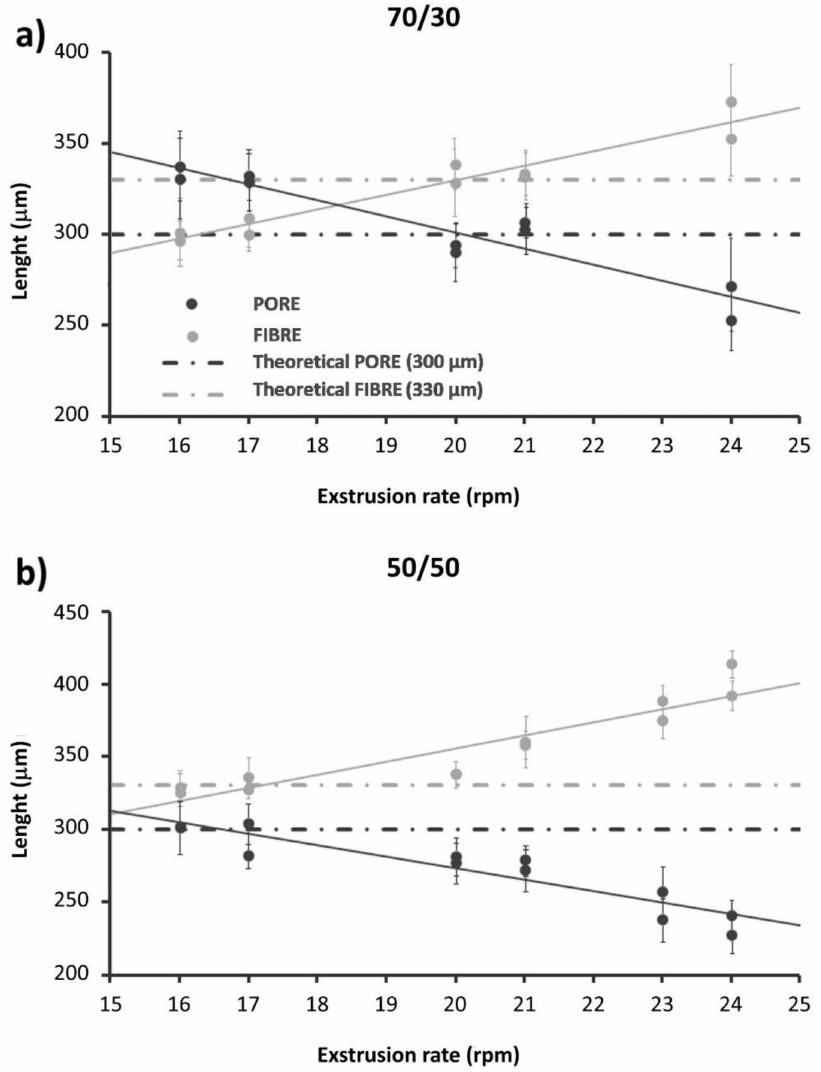
Figure 1. Fibre diameter (FIBRE, light grey) and pore size (PORE, hard grey) as a function of the extrusion rate, evaluated by optical microscope for ( a ) 70/30 and ( b ) 50/50 scaffolds. ImageJ software for dimensional analysis of fibres and pores was used. The results are reported as mean ±